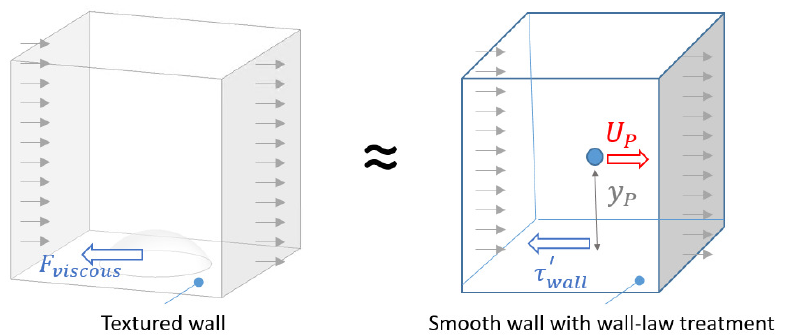
Figure 1. Sketch representing the concept of the effective viscosity wall law for textured